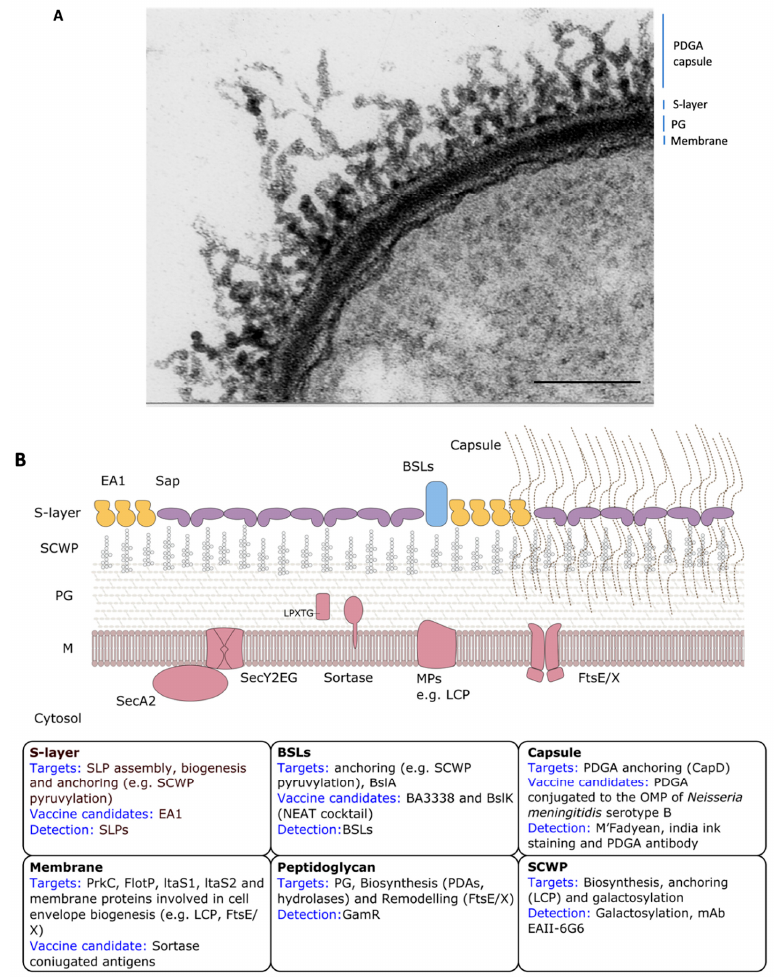
Figure 1. B. anthracis cell envelope organization. ( A ) Electron micrograph of a negative stained capsulated B. anthracis thin section. Adapted from Mesnage et al., 1998 [20]. Scale bar is 250 nm. ( B ) Schematic representation of cell envelope organization in presence or absence of poly- γ - d -glutamic acid (PDGA) capsule (right and left, respectively). Therapeutic targets, vaccine candidates, and detection targets are reported for each cell envelope component in the respective insets. Cell-wall components are indicatedassuchforbothpanels: cytosolicmembrane(M),peptidoglycanlayer(PG),secondarycell-wall polysaccharides (SCWP), surface layer (S-layer), Bacillus anthracis S-layer-associated proteins (BSLs), and